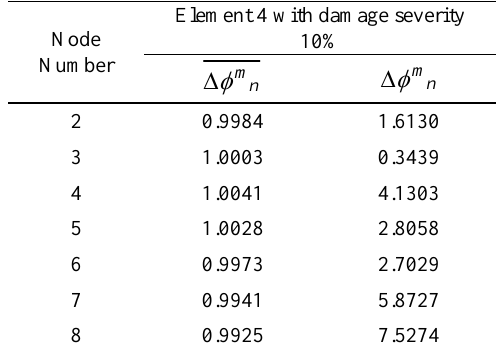
Table 2 Mode shape ratios before and after transformation Element 4 with damage severity 10% Node